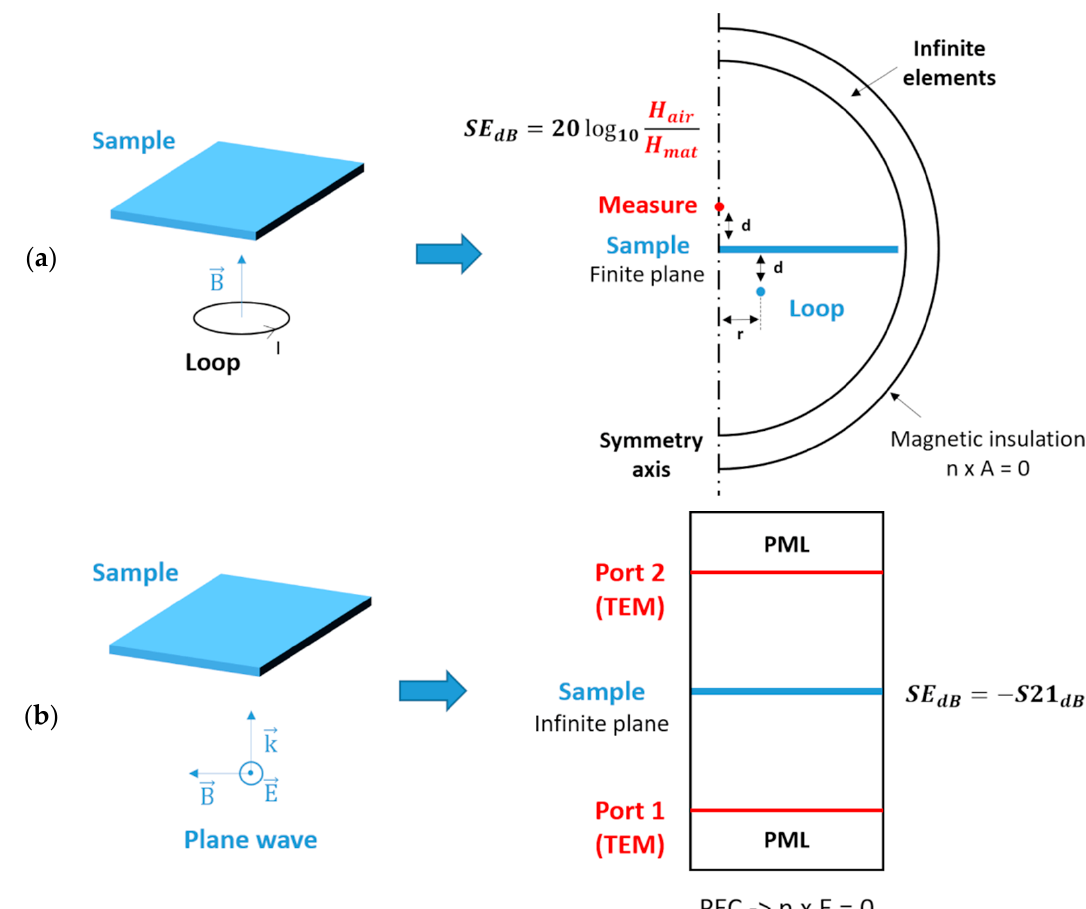
Figure 1. Schematic diagrams of the numerical model in the near-field ( a ) and far-field ( b ).